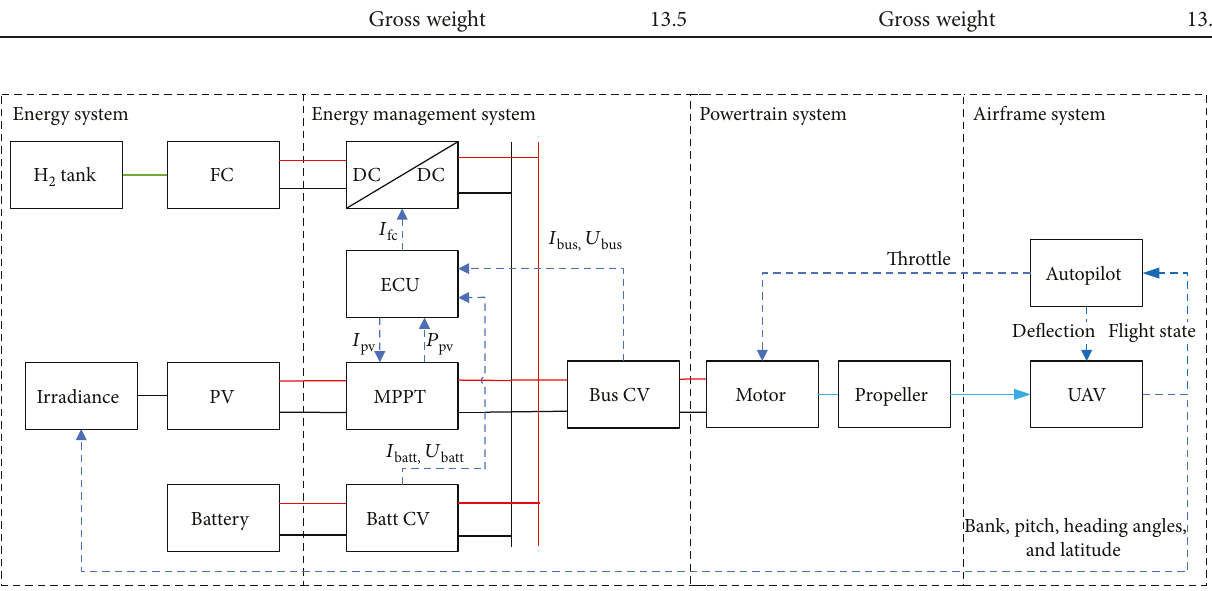
Figure 1: Topology of the hybrid electric UAV